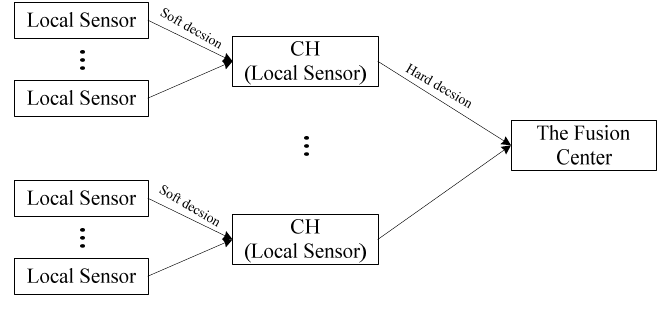
Figure 4. The proposed clustered system.